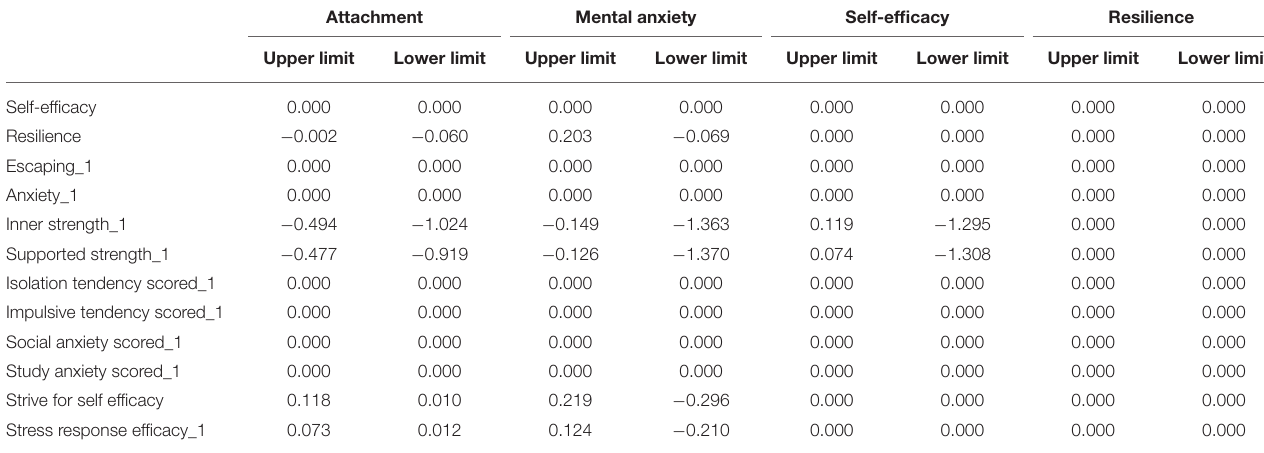
TABLE 9 | The upper limit and lower limit of bias-correction confidence interval. Attachment Mental anxiety Self-efficacy Resilience Upper limit Lower limit Upper limit Lower limit Upper limit Lower limit Upper limit Lower